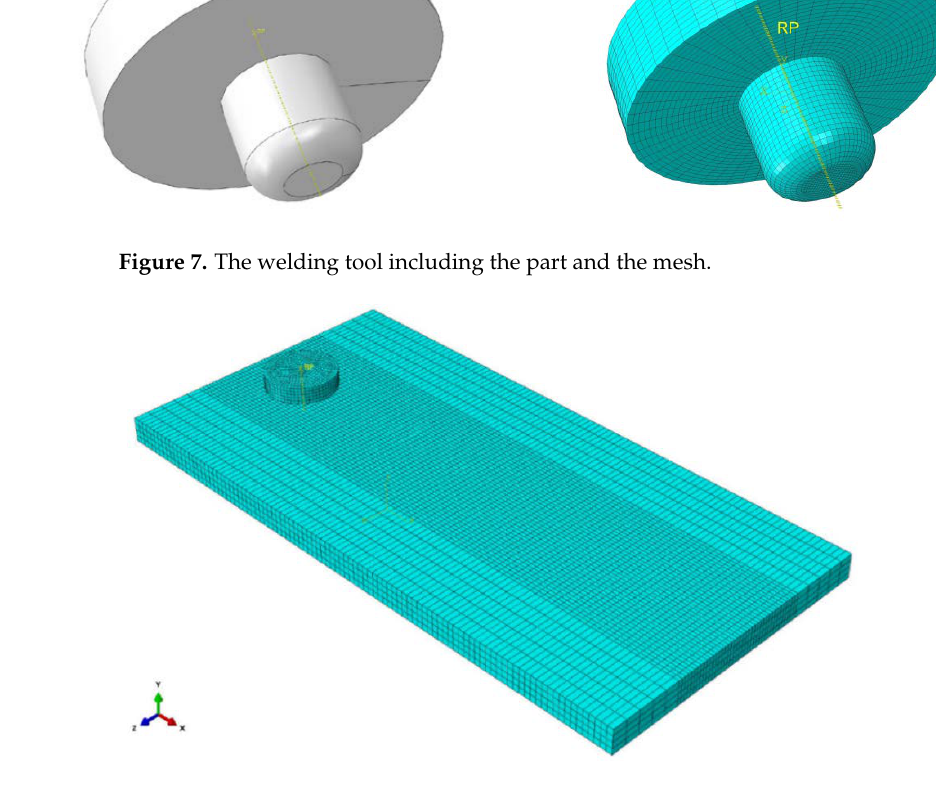
Figure 8. Schematic view of the assembled model.